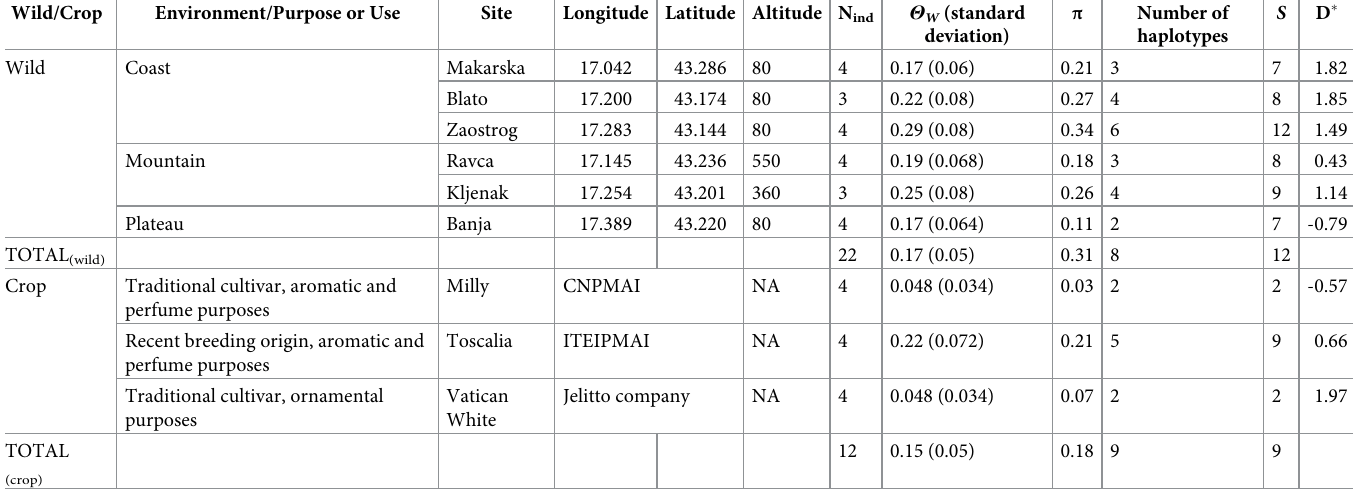
Table 1. Genetic polymorphism for the wild and cultivated clary sages, Salvia slarea L., estimated with the concatenated haploid sequences from the ITS 1, DXS2 and CMK loci ( N = 68 haploid